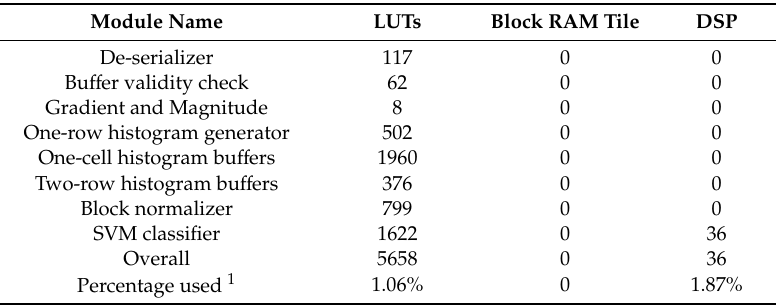
Table 4. HOG-SVM IP-core resources.